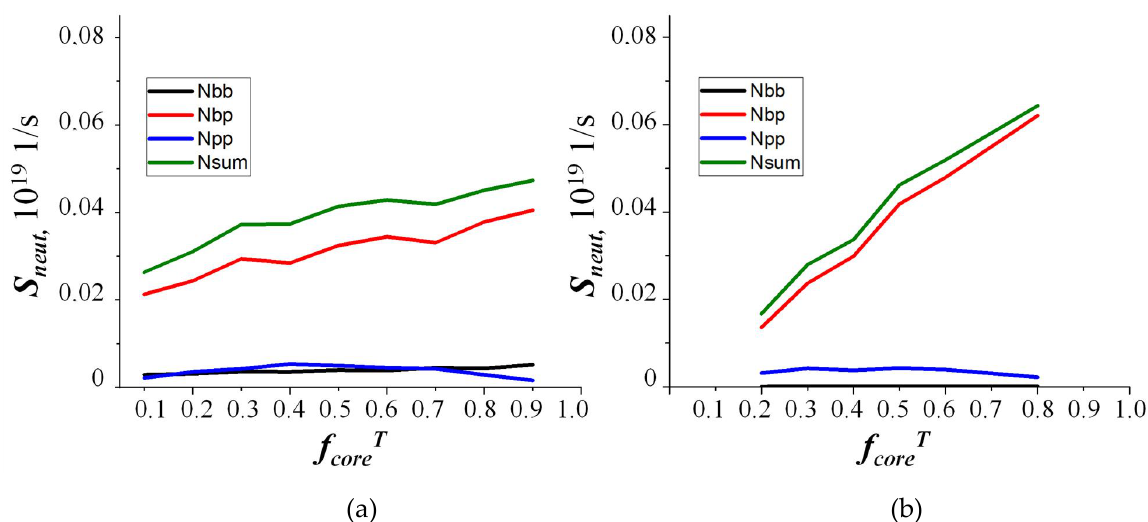
The NUBEAM-ASTRA calculations show that for both the D + T and D beams, an increase in the tritium fraction in the core plasma f core is beneficial for the neutron yield S neut . The simulation results are shown in Figure 2. In the calculations with varying f core , the isotope composition of the D + T beam was taken unchanged such that f NBT = 0.5.